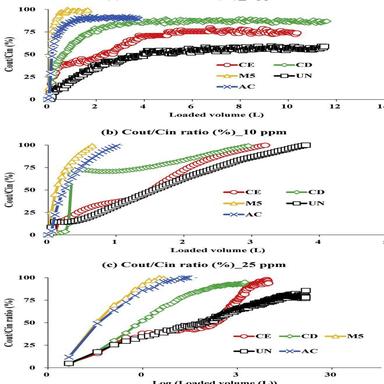
Breakthrough performances of the tested adsorbents toward high FA concentrations (5–25 ppm) (ambient temperature and 2 mg adsorbents).